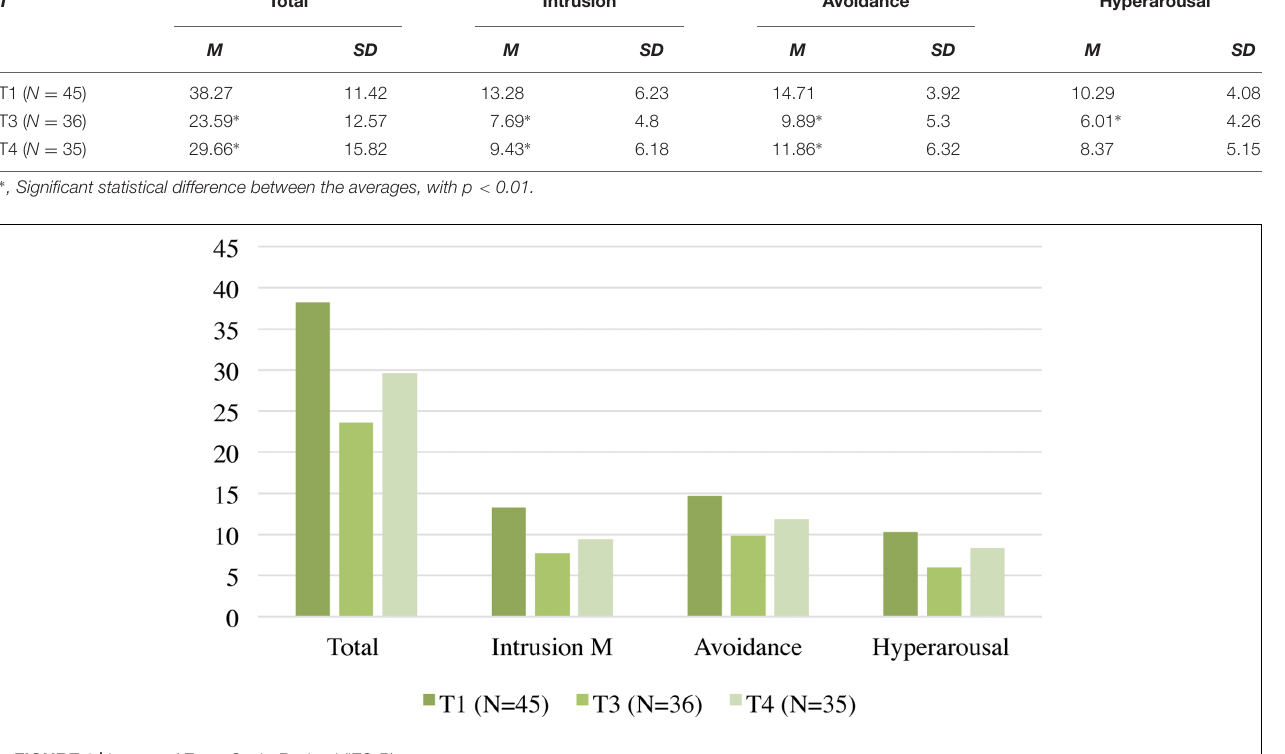
FIGURE 1 | Impact of Event Scale-Revised (IES-R)